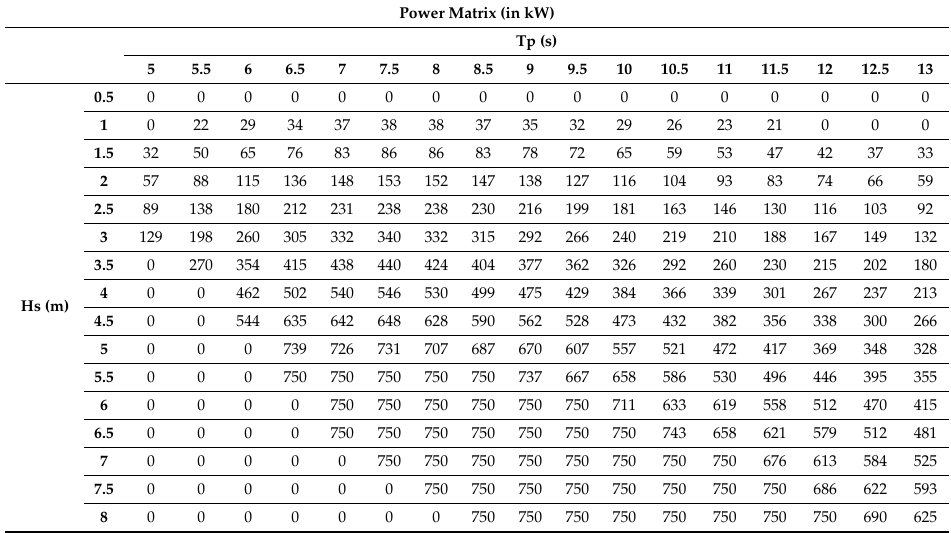
Table 2. Power matrix of D1, Hs being the significant wave height and Tp the peak wave period (“wave period with the highest energy” [54])